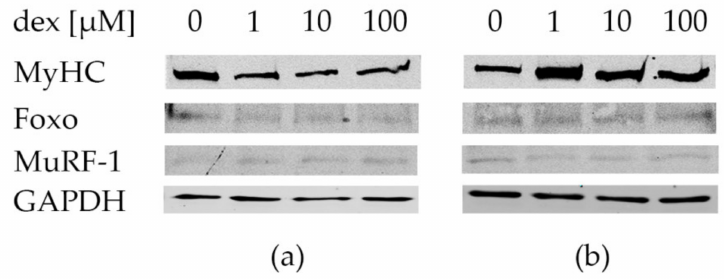
Figure 6. Western blot of di ff erentiated myotubes after dex treatment. Myotubes were incubated with 1, 10, and 100 µ M dex for 48 ( a ) and 72 h ( b ). Control cells were incubated without dex (0) and Myosin (MyHC), Foxo, and MuRF-1 protein expressions were detected. GAPDH was used as the loading